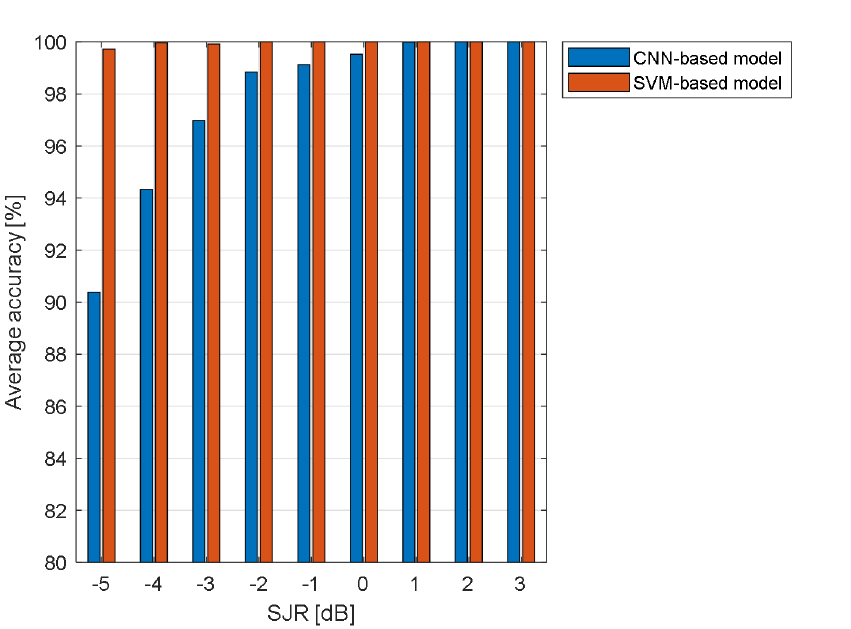
Figure 11. Results of the proposed SVM-Based and CNN-based classification methods when LG modes are considered.